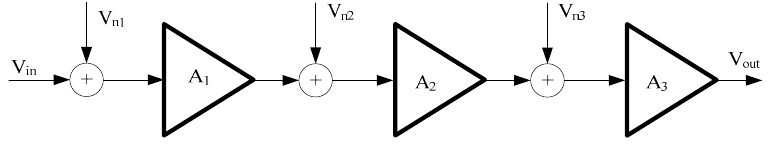
Figure 4. Noise of opened-loop system